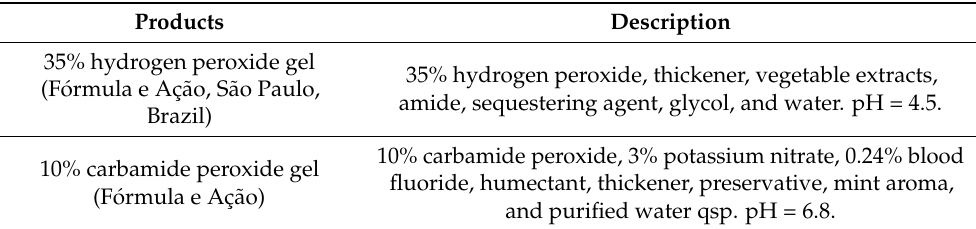
Table 2. Description of the bleaching products